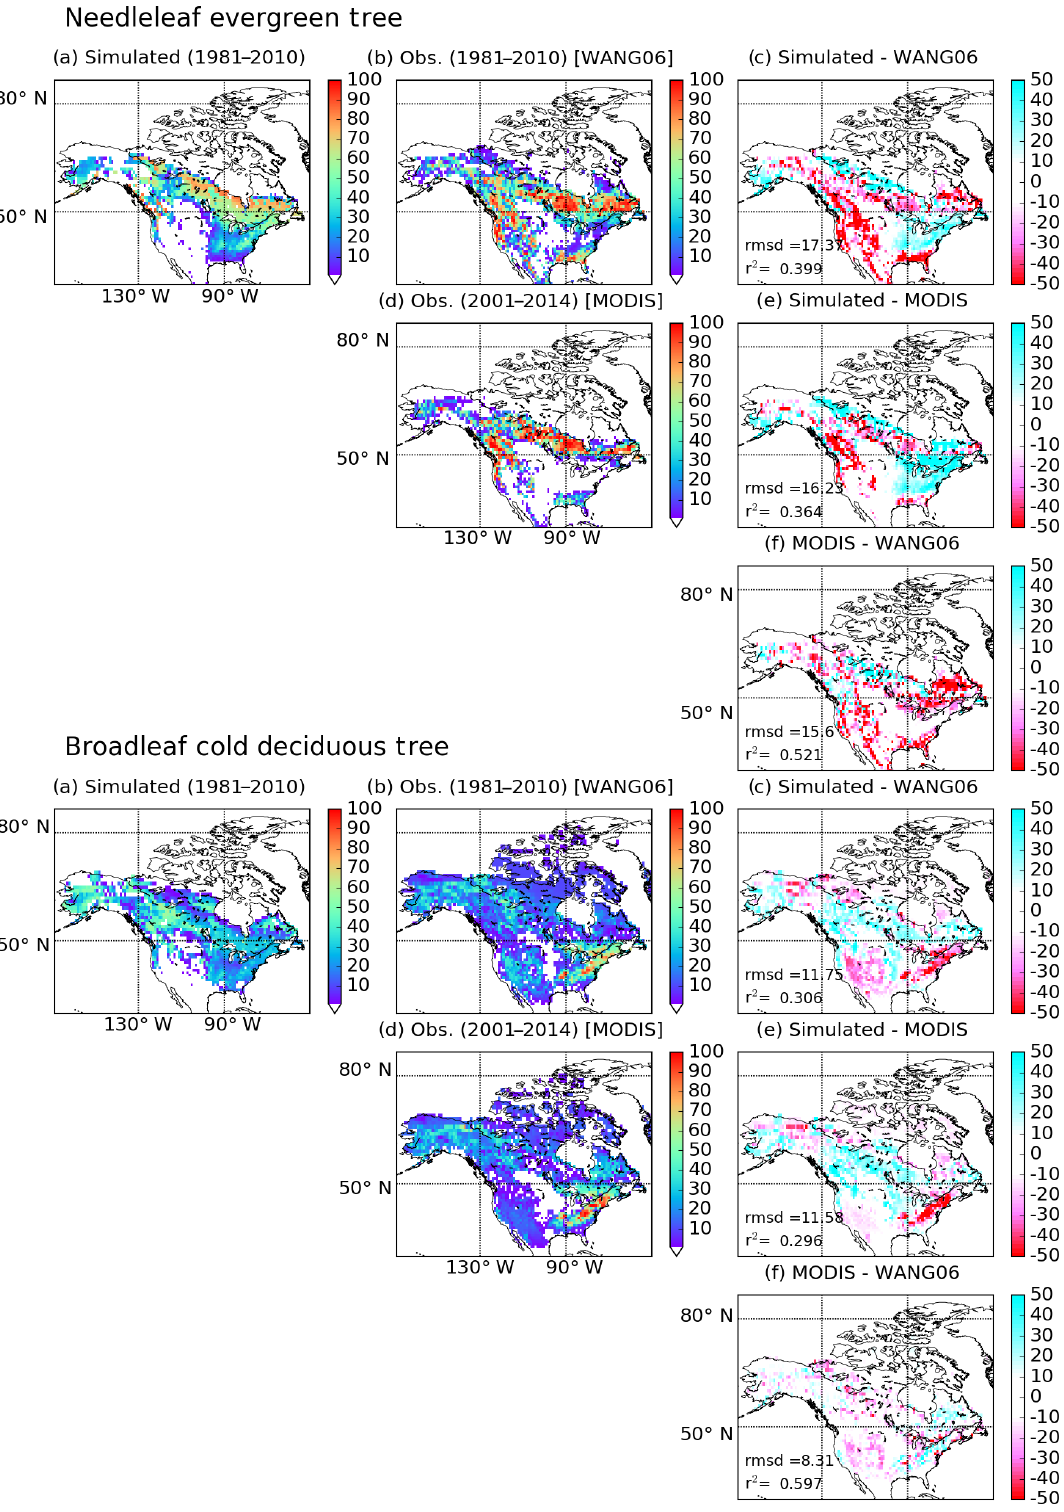
Figure 7. Spatial distribution of needleleaf trees (upper section) and broadleaf cold deciduous trees (lower section) across North America. Model-simulated results are shown in the left column (a) and the two observation-based estimates are shown in the middle column (b, d) . The right column (c, e, f) shows the difference between model- and observation-based estimates (simulated minus WANG06 in c , and simulated minus MODIS in e ), and the observation-based estimates themselves (MODIS minus WANG06 in f ) along with the root mean square difference (rmsd) and spatial correlation ( R 2 ) between the two estimates being